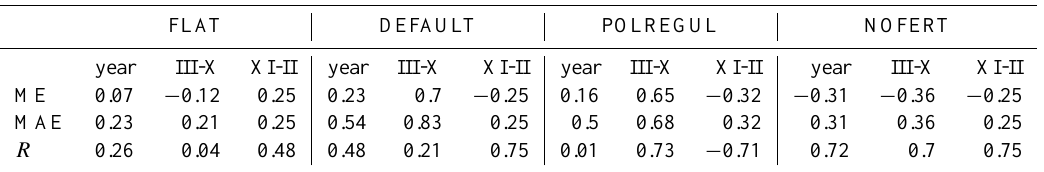
Table 6. FRAME error results – error statistics from all sites for summer (III-X) and winter (XI-II) period. Unit for ME and MAE is µgm − 3 , R is unitless.